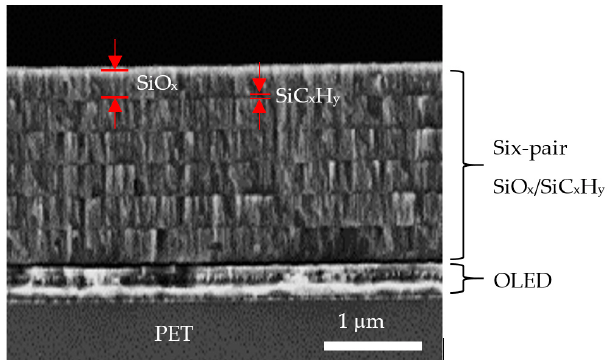
Figure 5. Cross-sectional scanning electron microscope image of the OLED device with six-pair SiO x /SiC x H y encapsulation.